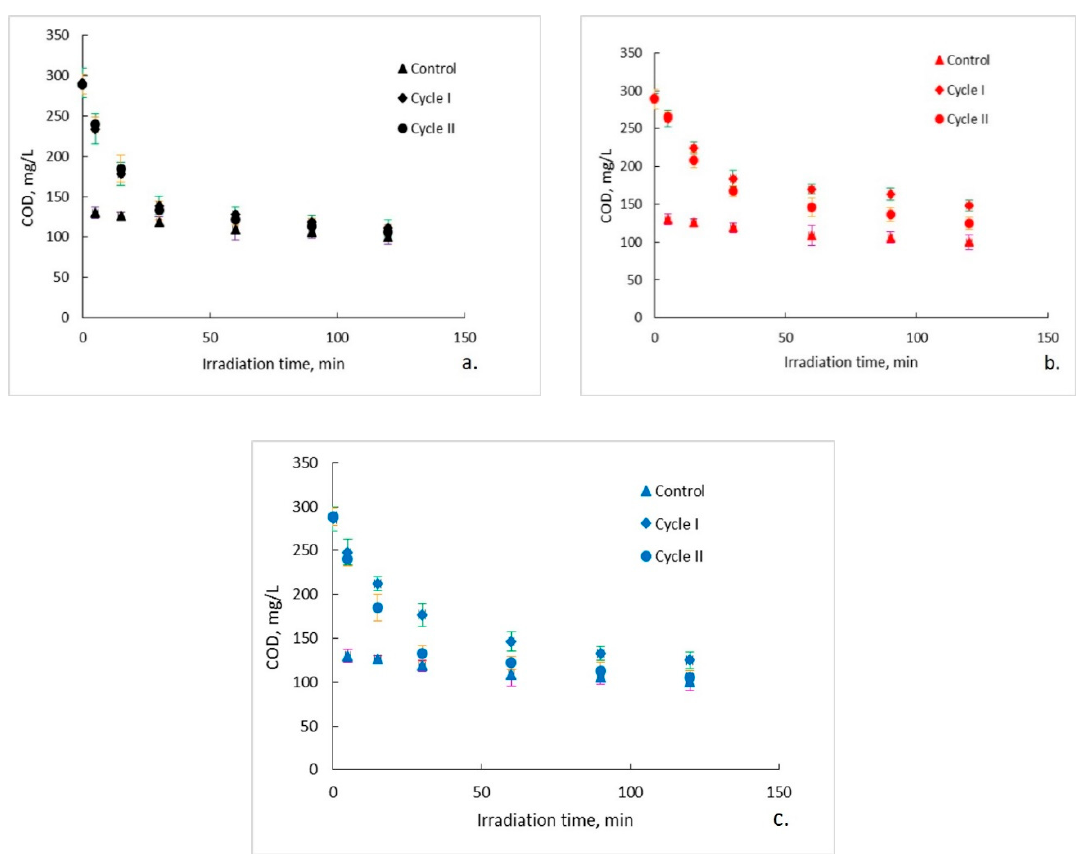
Figure 2. Photocatalytic degradation of ampicillin: ( a ) fiberglass fabric plain woven-type membrane (EWR); ( b ) fiberglass mat-type membrane (EMC); ( c ) fiberglass fabric one fold edge-type membrane (TEX). Error bars represent the calculated standard deviation for the experimental data. Cycle I—green error bars; Cycle II—orange error bars; Control—purple error bars.